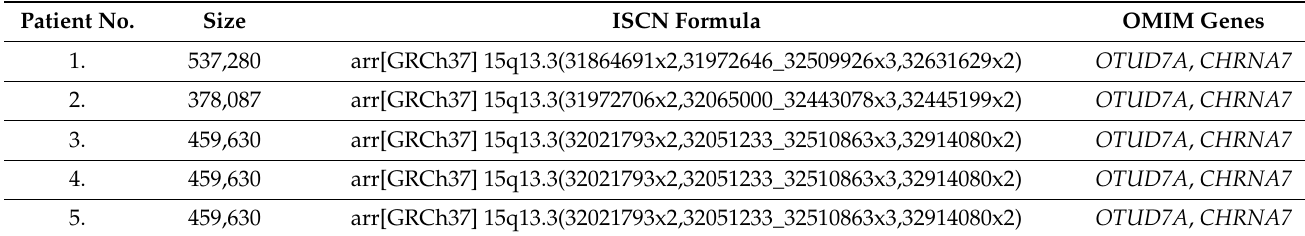
Table 2. Summary of the genomic characteristics of 15q13.3 duplicated regions in our patients. Patient